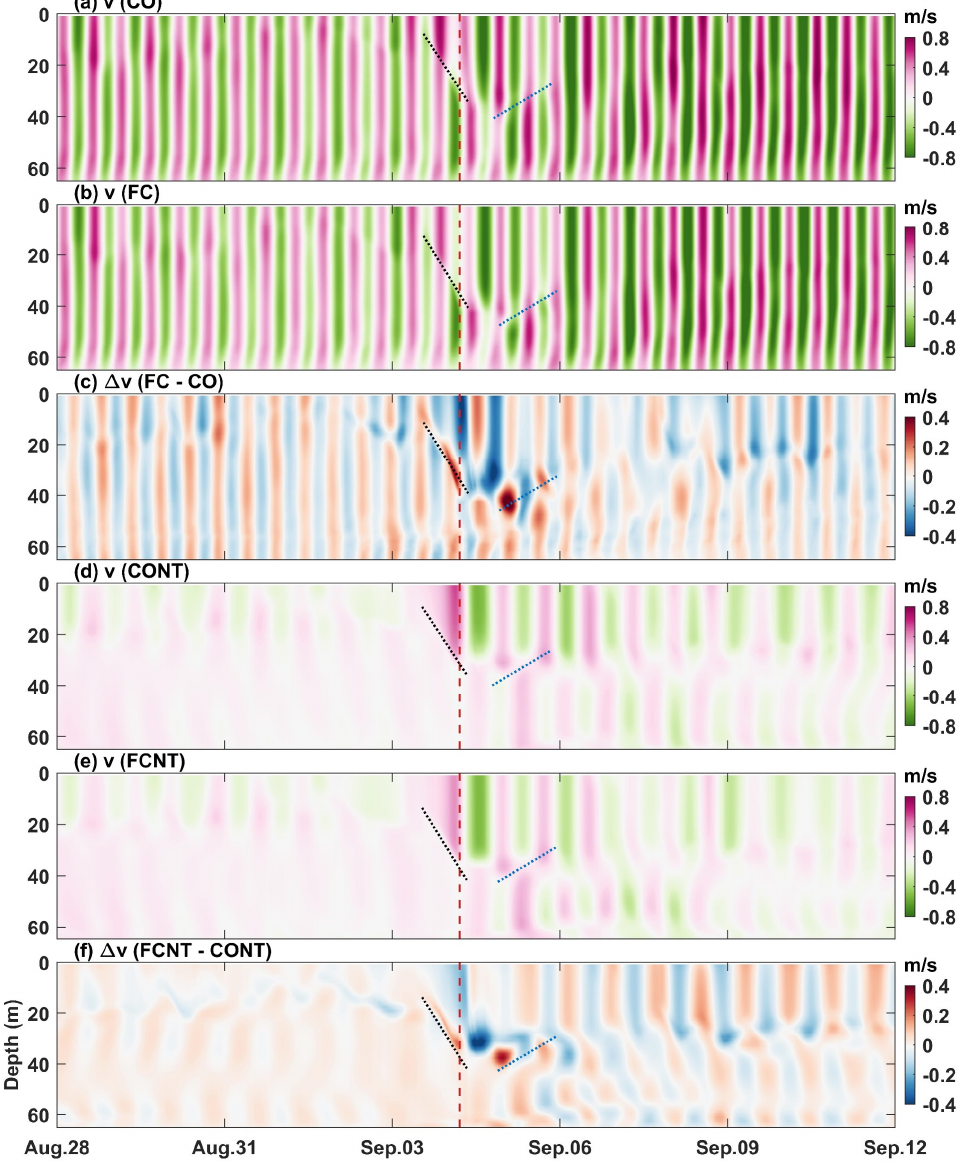
Figure 11. Time series of ( a , b , d , e ) meridional current profiles at buoy 44008 in different model runs and the differences ( c ) between runs FC and CO and ( f ) between runs FCNT and CONT. Red dashed lines mark the time (0500 UTC 4 September) when the storm reached the buoy. Dotted lines in ( a − c ) mark the interface with strong current shears.